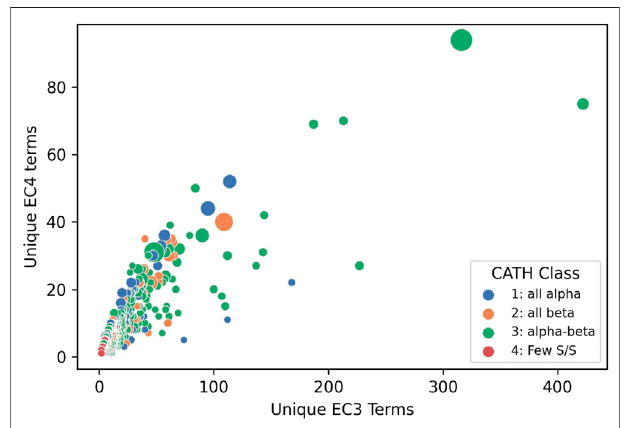
FIGURE 10 | Enzyme Commission terms distributions for each CATH v4.3SuperFamilies,showingthat65superfamilieshavemorethan20different chemistries (i.e.